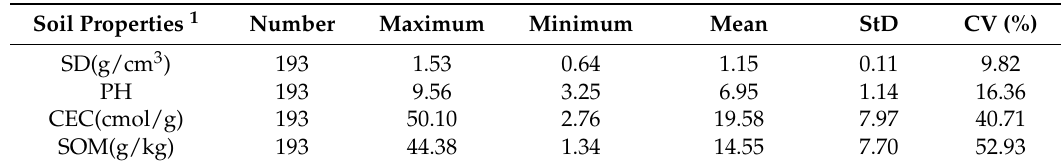
Table 1. Statistical description of soil properties in soil